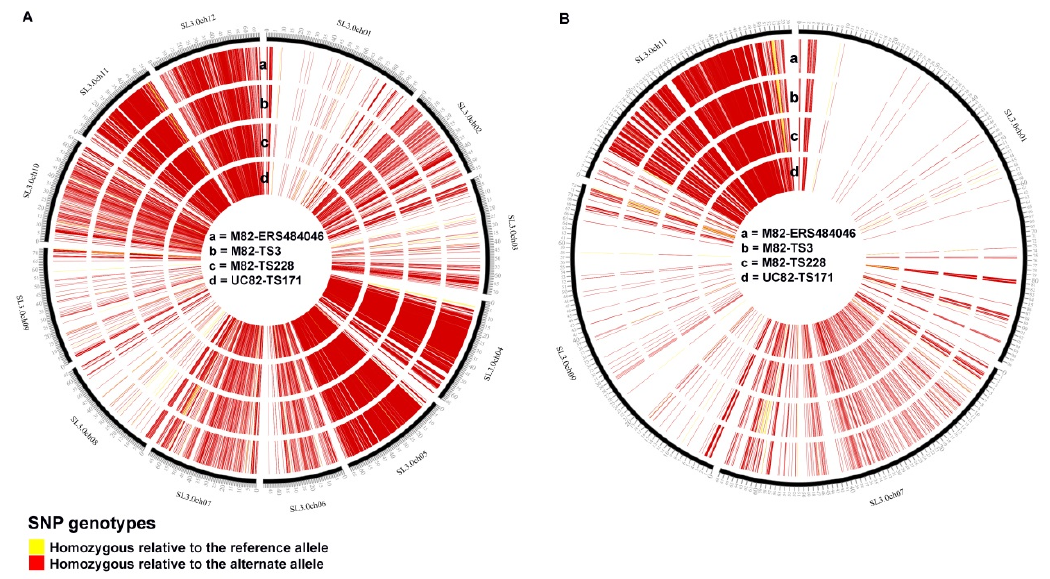
Figure 2. ( A ) SNP allele comparison across the entire genome sequence among samples M82-ERS484046, M82-TS3, M82-TS228, and UC82-TS171. ( B ) SNP allele comparison magnification of